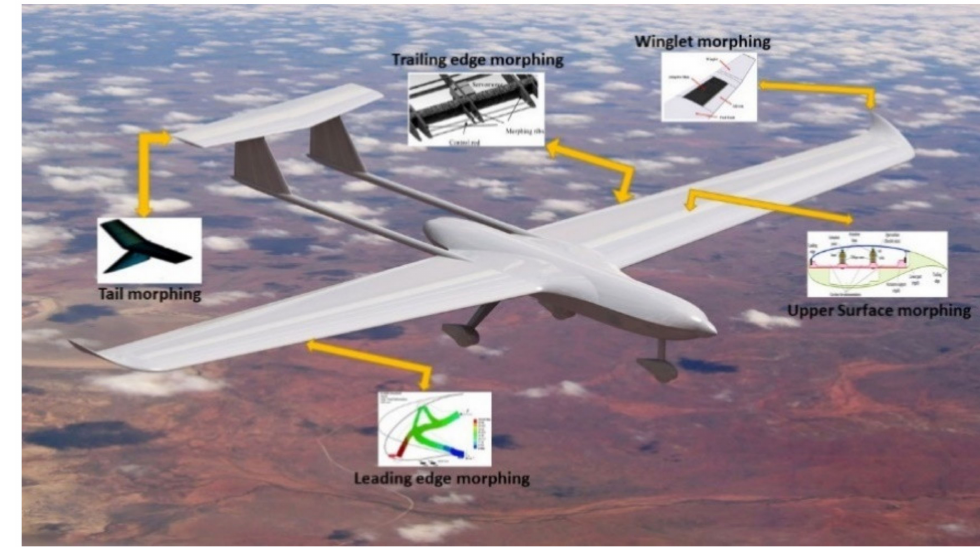
Figure 1. UAS-S45 with Potential Morphing Configuration